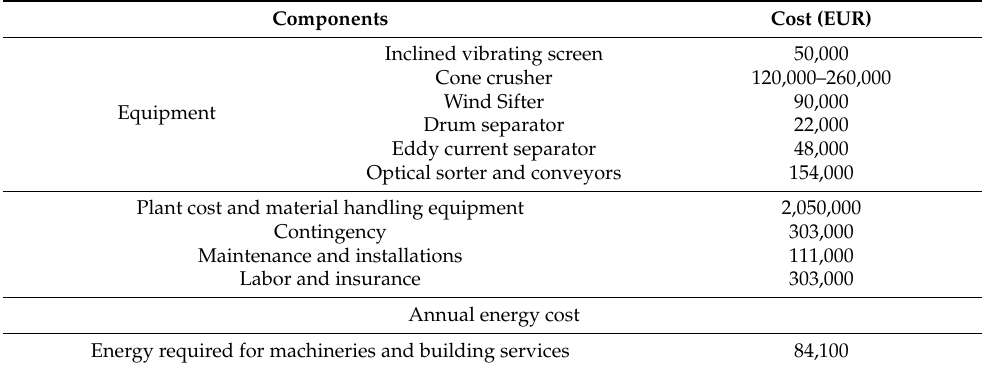
Table 5. Required annual investment and energy cost for CDW treatment